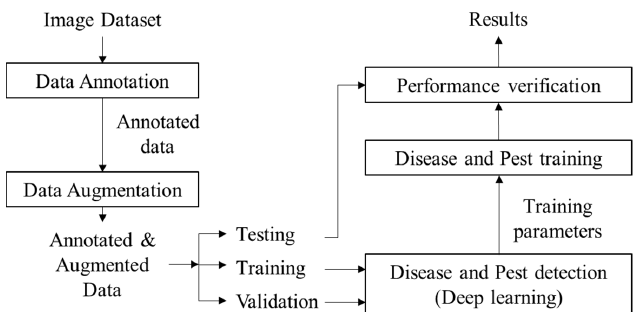
Figure 4. System overview of the proposed deep-learning-based approach for plant diseases and pest recognition. Our deep meta-architecture approach consists of several steps that use input images as a source of information, and provide detection results in terms of class and location of the infected area of the plant in the image.